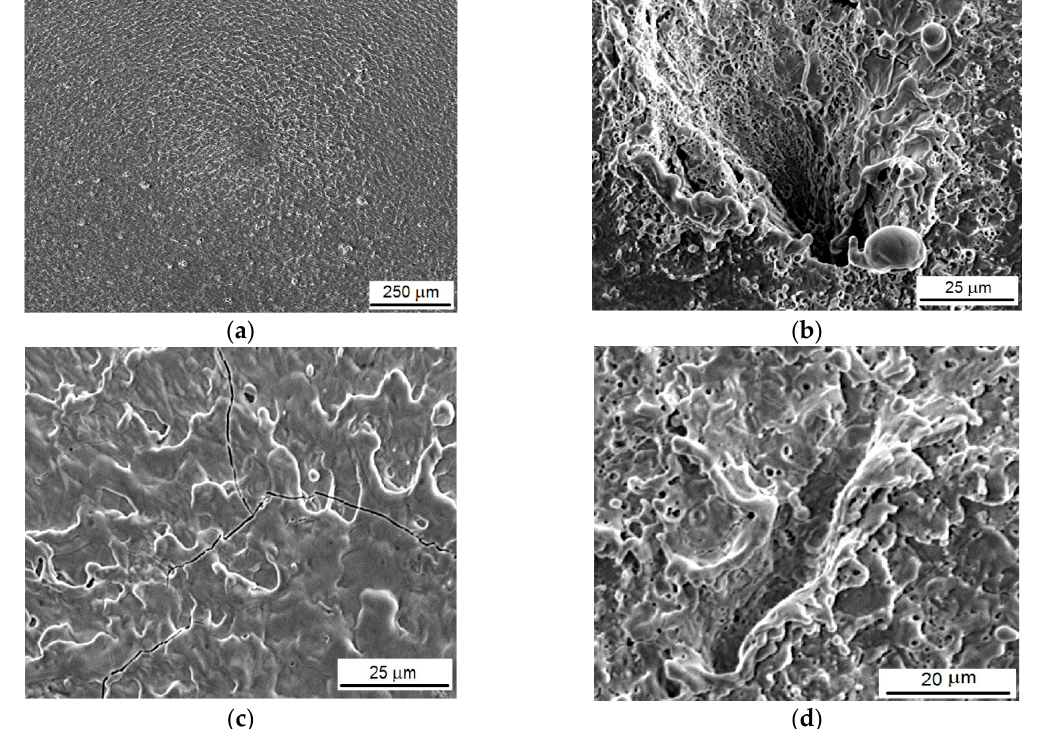
Figure 5. ( a – d ) Bulk W: SEM micrographs at different magnifications of the area irradiated by the laser pulse.